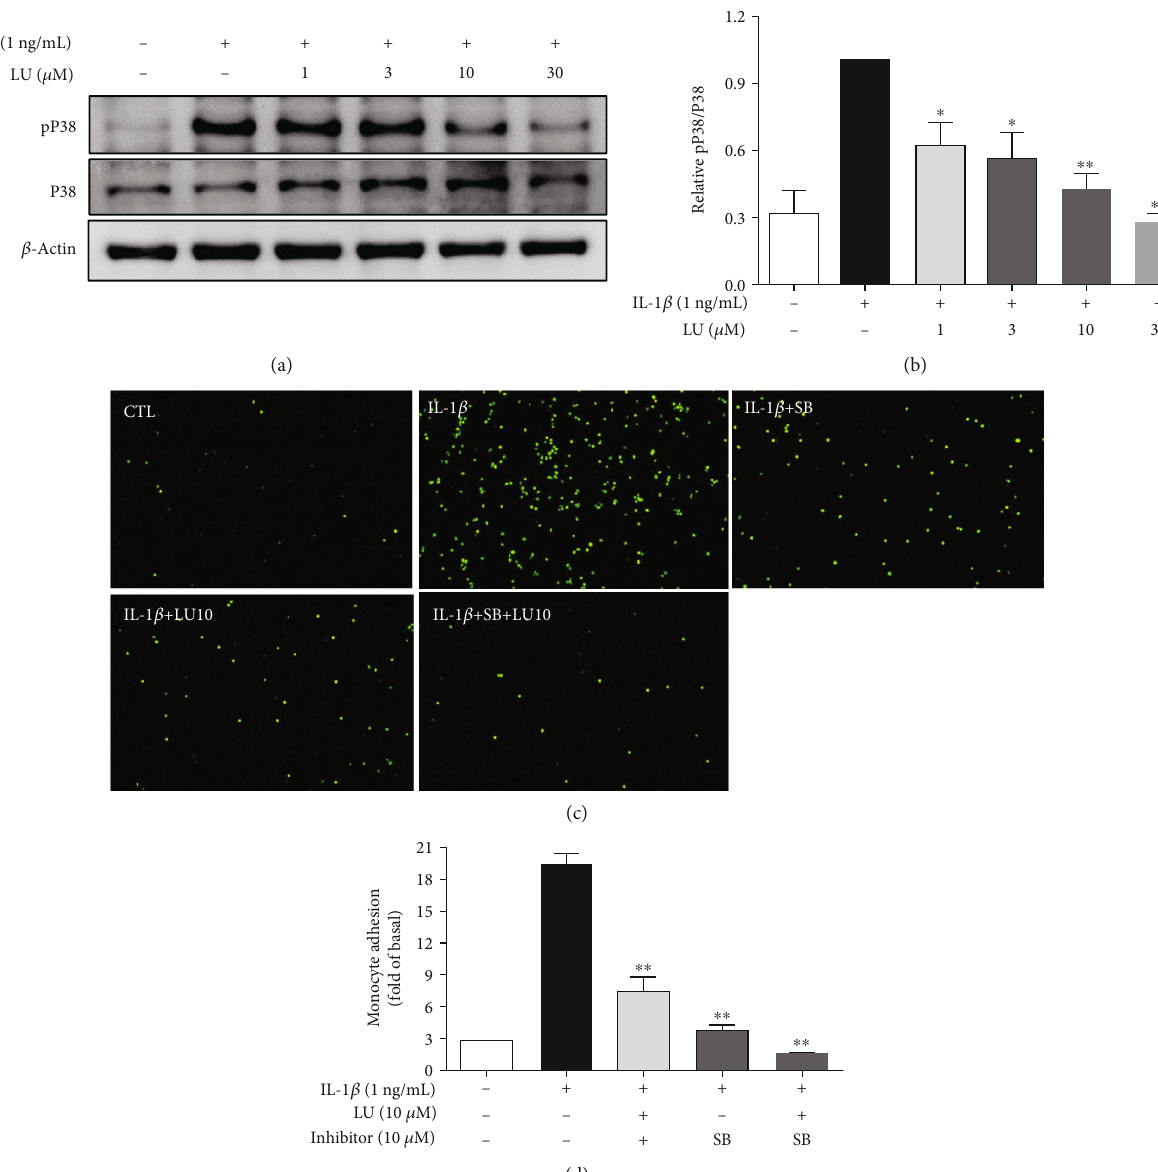
Figure 7: Luteolin blocked P38 phosphorylation, and the P38 inhibitor SB202190 (SB) decreased THP-1 cell adherence to IL-1 β -stimulated ARPE-19 cells. (a) Western blots show levels of phosphorylated P38 protein expression. (b) The fold-change in pP38 protein expression was measured relative to P38 expression. (c) ARPE-19 cells were pretreated with 10 μ M luteolin or P38 inhibitor (SB203580) for 1h and then cocultured with labeled THP-1 cells. (d) The fl uorescence intensity was used to quantify calcein-AM fl uorescence. Data represent the mean ± SD . ∗ p < 0 : 05 , ∗∗ p < 0 : 01 , compared to ARPE-19 cells stimulated with IL-1 β